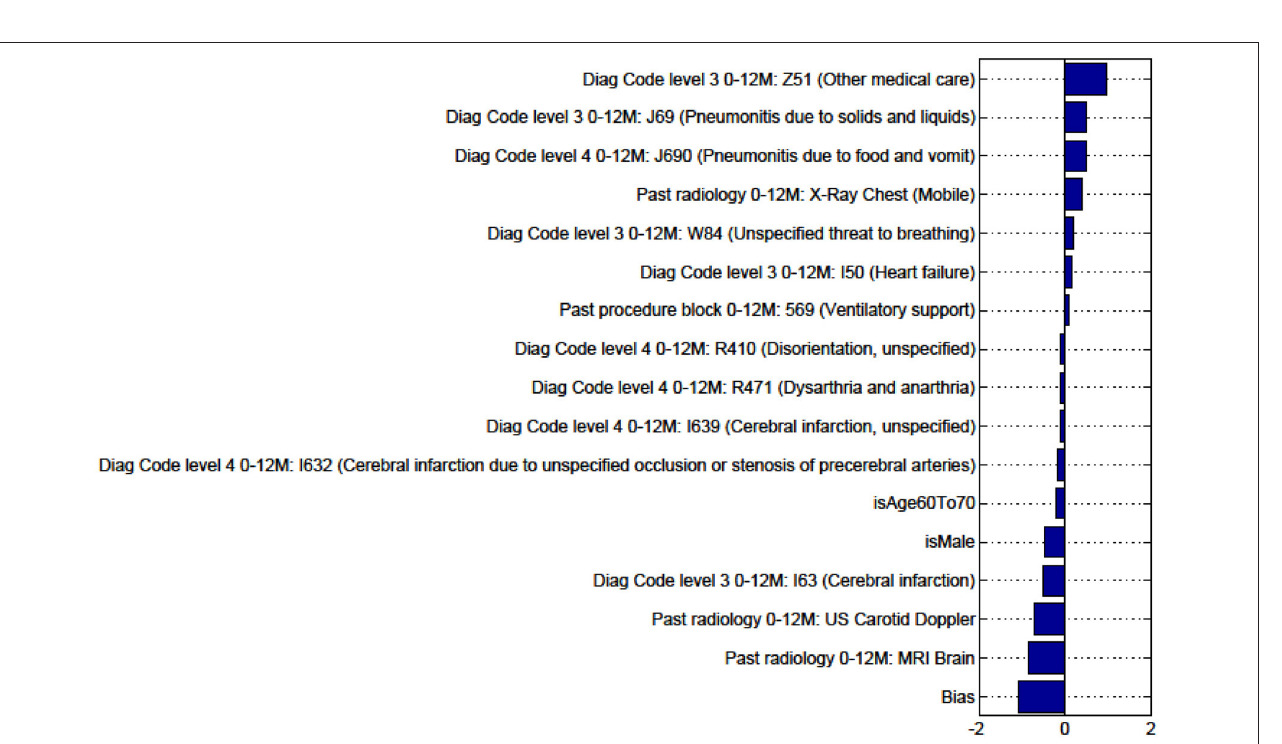
Frontiers in Neurology |